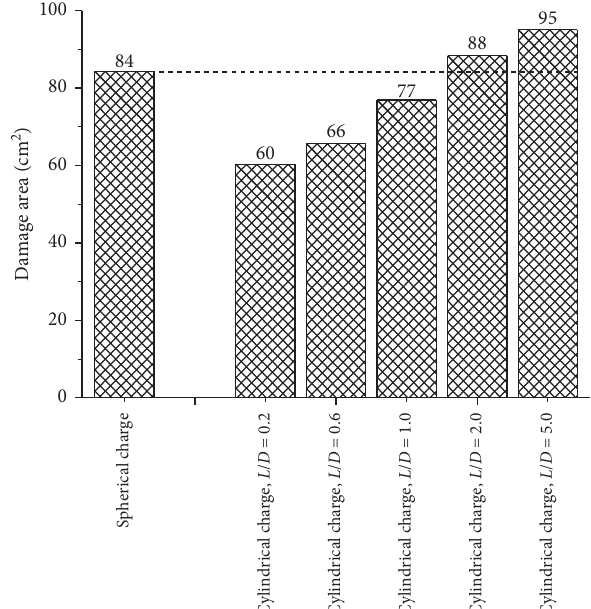
Figure 20: Spall damage areas at bottom surface of the slabs from the spherical and cylindrical explosives.